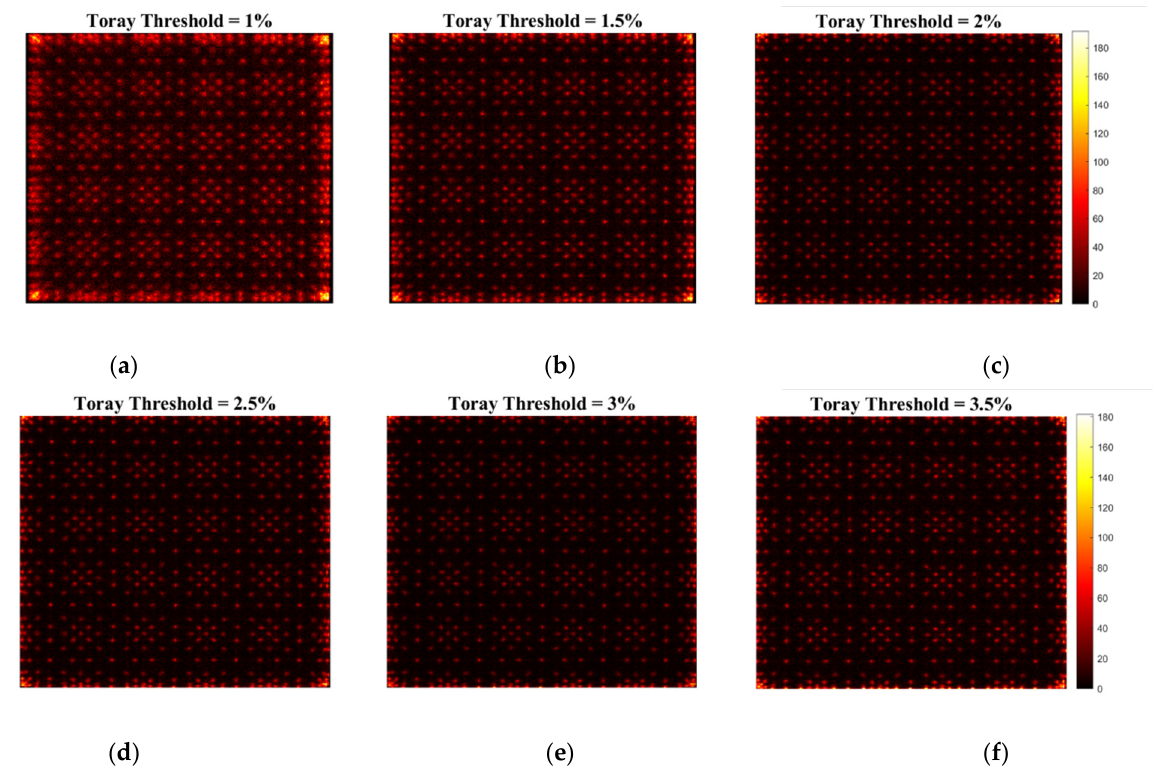
Figure 5. The flood histograms calculated from the experimental data of the dual-layer-offset crystal array constructed with Toray reflectors: ( a ) threshold = 1%, ( b ) threshold = 1.5%, ( c ) threshold = 2%, ( d ) threshold = 2.5%, ( e ) threshold = 3%, and ( f ) threshold = 3.5%.